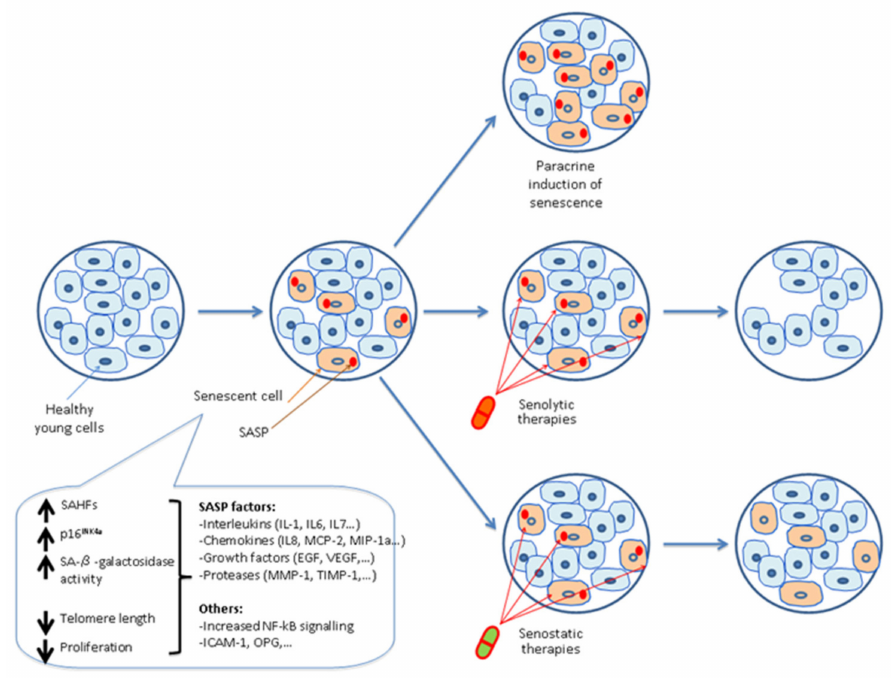
Figure 3. Scheme of senotherapeutics as a new pharmacological category of